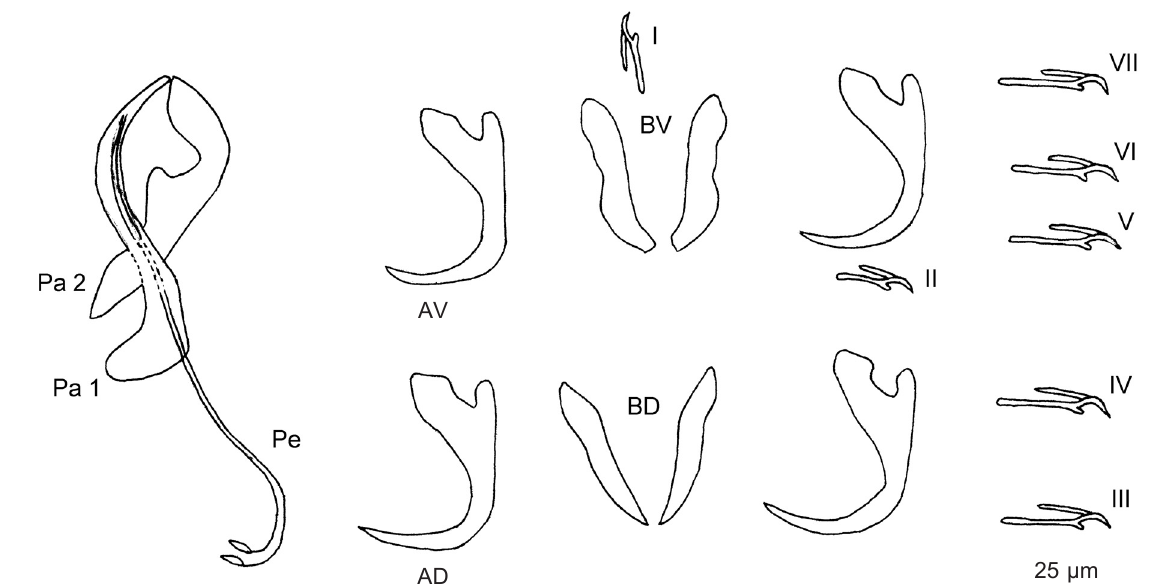
Fig. 3. – Bouixella yaoi n.